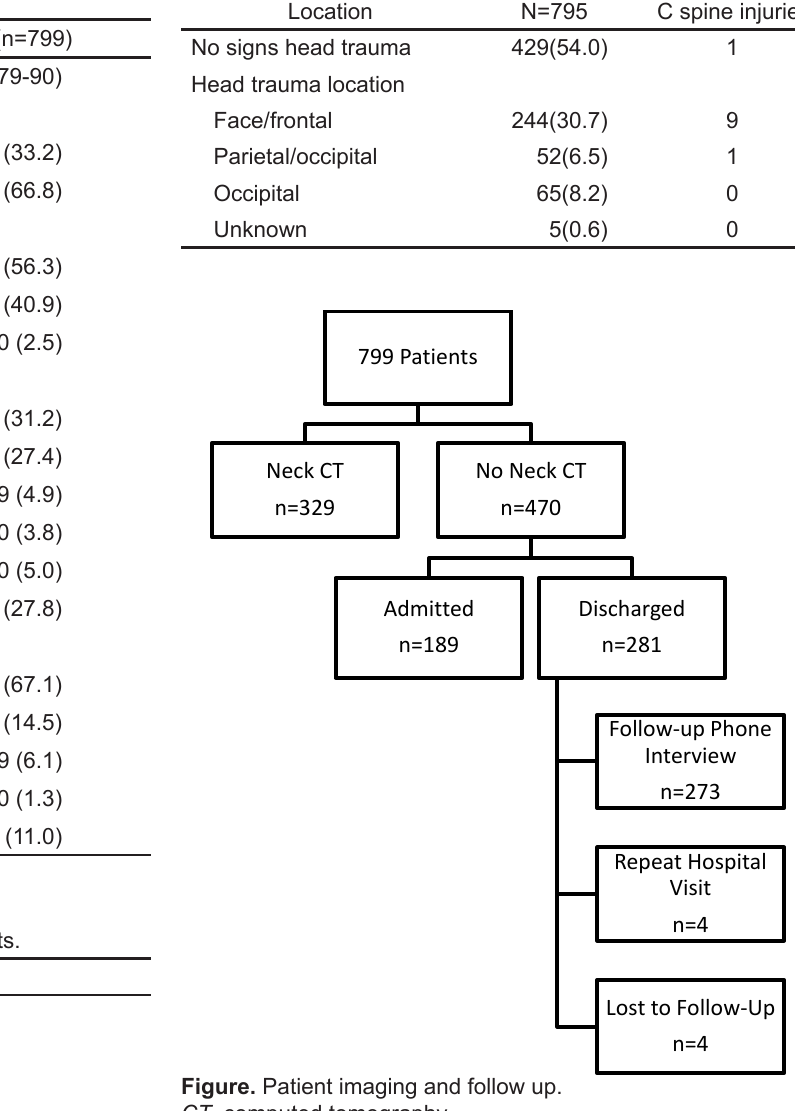
Table 3. Head trauma location and cervical spine injury.